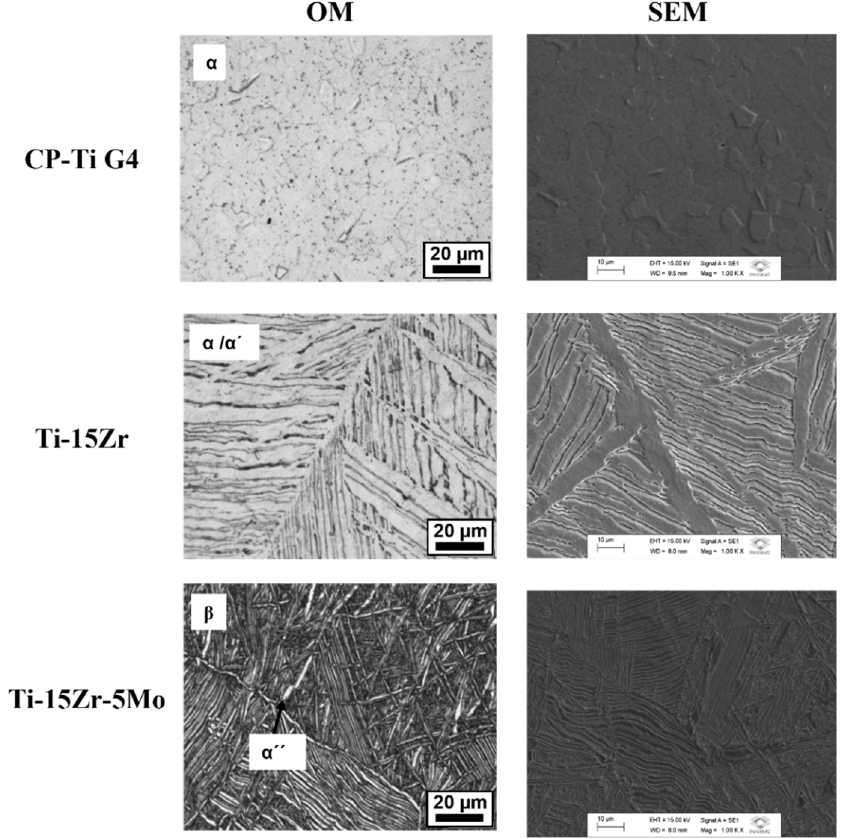
Figure 3. OM and SEM of the